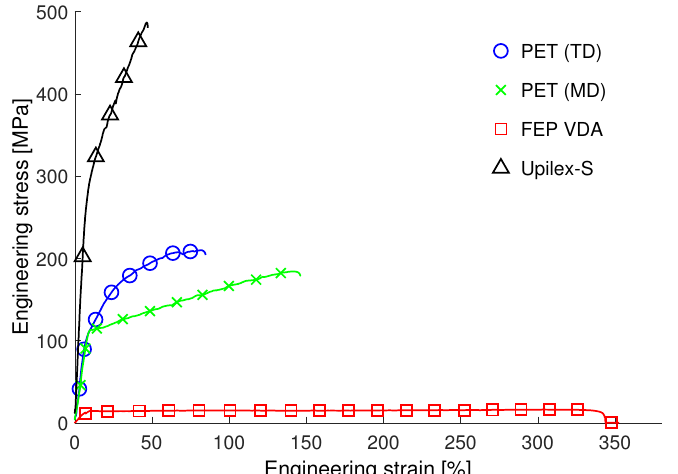
Figure 6. Results of the tensile experiments on non-irradiated FEP VDA, PET and Upilex-S VDA micro-samples. The materials show a large variation in their tensile behaviour. Additionally, the PET foils exhibit a distinct orientation dependency.